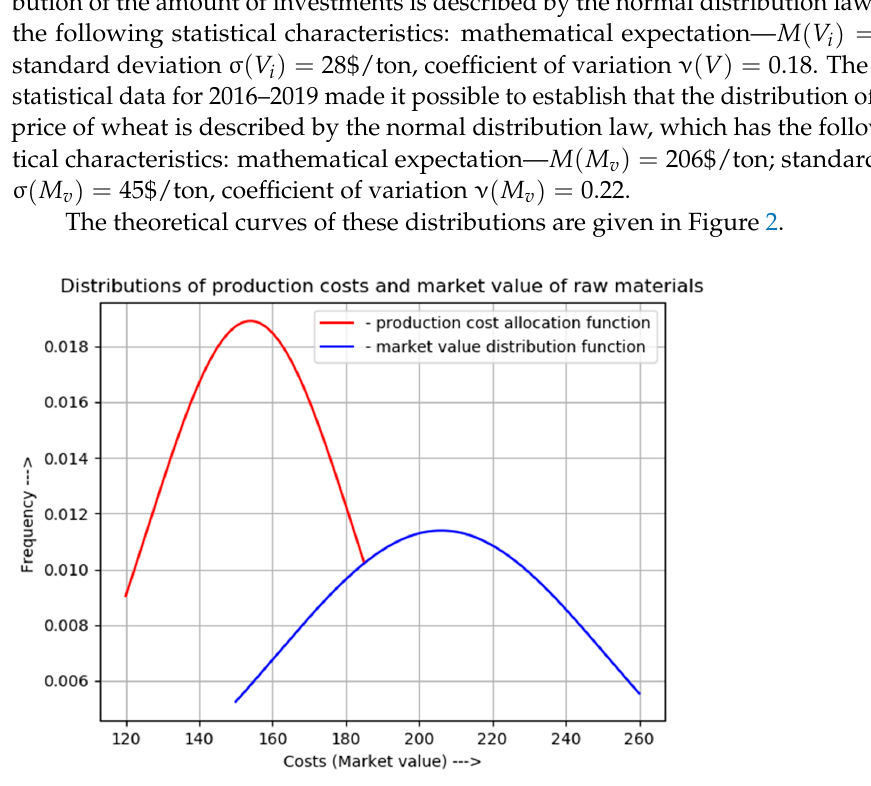
Figure 2. Theoretical curves of the amount of investments in the project of production of raw materials for bioethanol from wheat and its market value